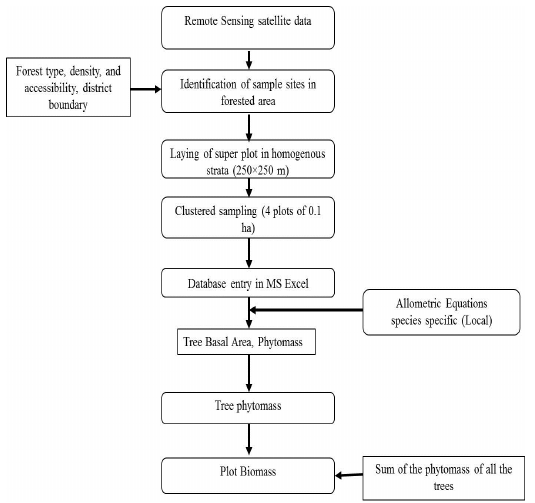
Figure 2. Flow chart showing the broad steps for phytomass